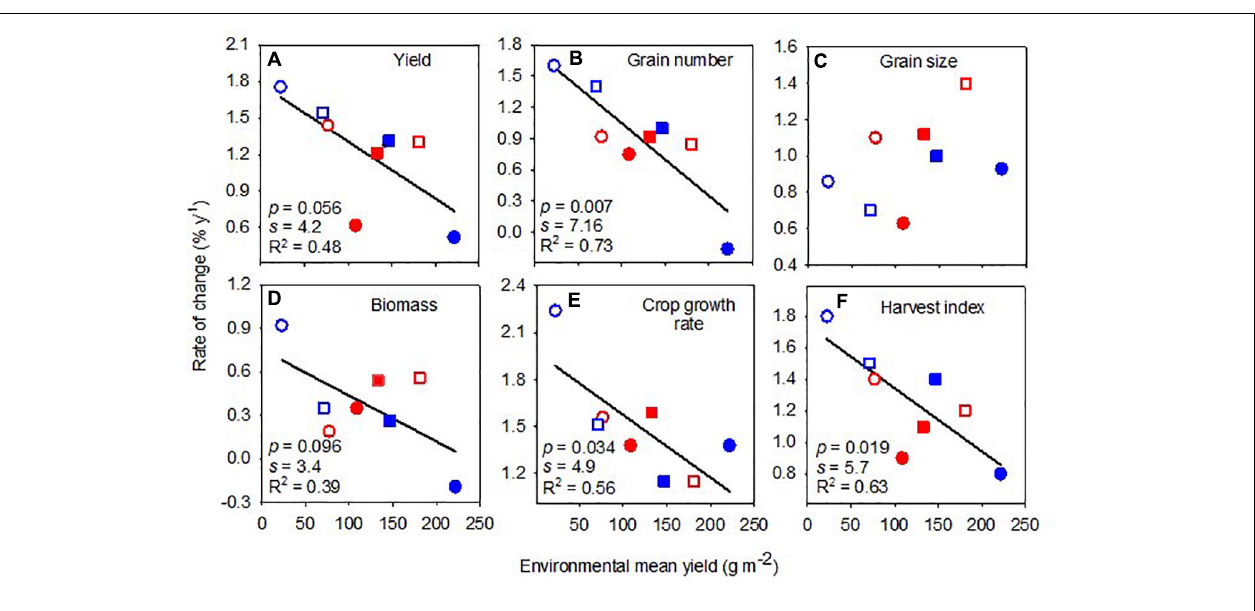
FIGURE 4 | Rate of change of yield (A) , grain number (B) , grain size (C) , biomass (D) , crop growth rate (E) , and harvest index (F) against environmental mean yield. Lines are least-square regressions. Rates are relative to the newest variety. Symbols are: blue (2018), red (2019), circles (early sowing), square (late sowing), open (rainfed), closed